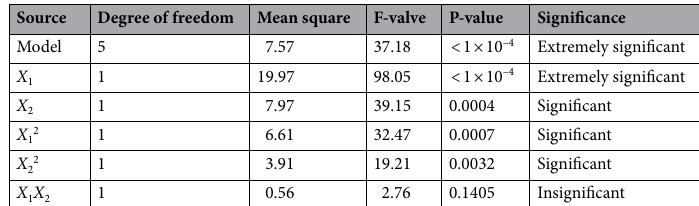
Table 4. Table of analysis of variance for quadratic model of gas concentration in upper corner.